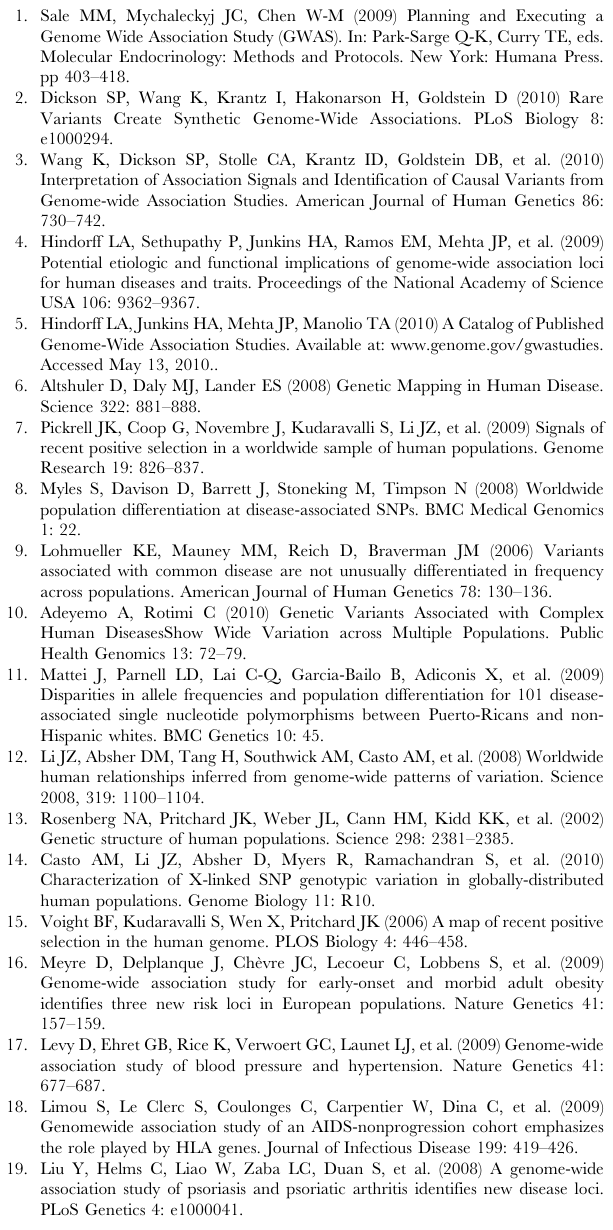
y-axis represents p-values for DEuropeCA. B) The same as in A) except that the x-axis represents LD Score in Europe. C,D) The same as in A,B) except that the y-axis represents p-values for LEurasiaLat.